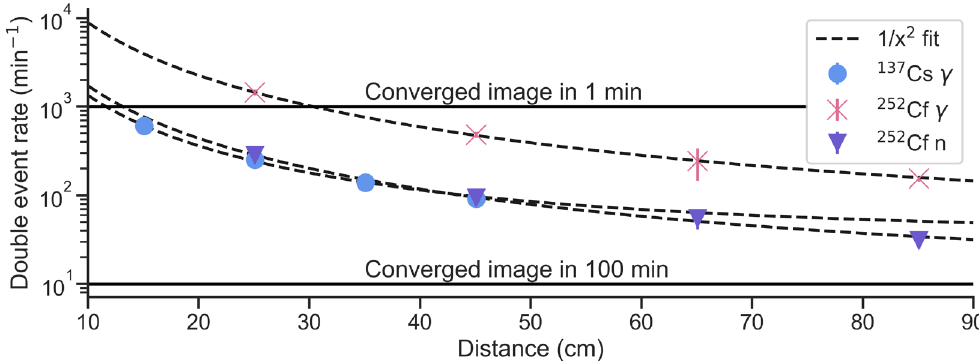
Figure 5. Double-scatter interaction rates (per minute) with distance of the source to the detector system for 100 µ Ci 137 Cs and 1 mCi 252 Cf sources. Inverse square law model fits are shown for illustration, alongside two lines that indicate the time needed to achieve a converged image (1000 double-scatter events). The error bars are often smaller than the